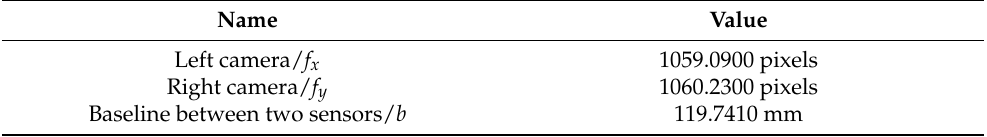
Table 3. Parameters of the binocular camera.